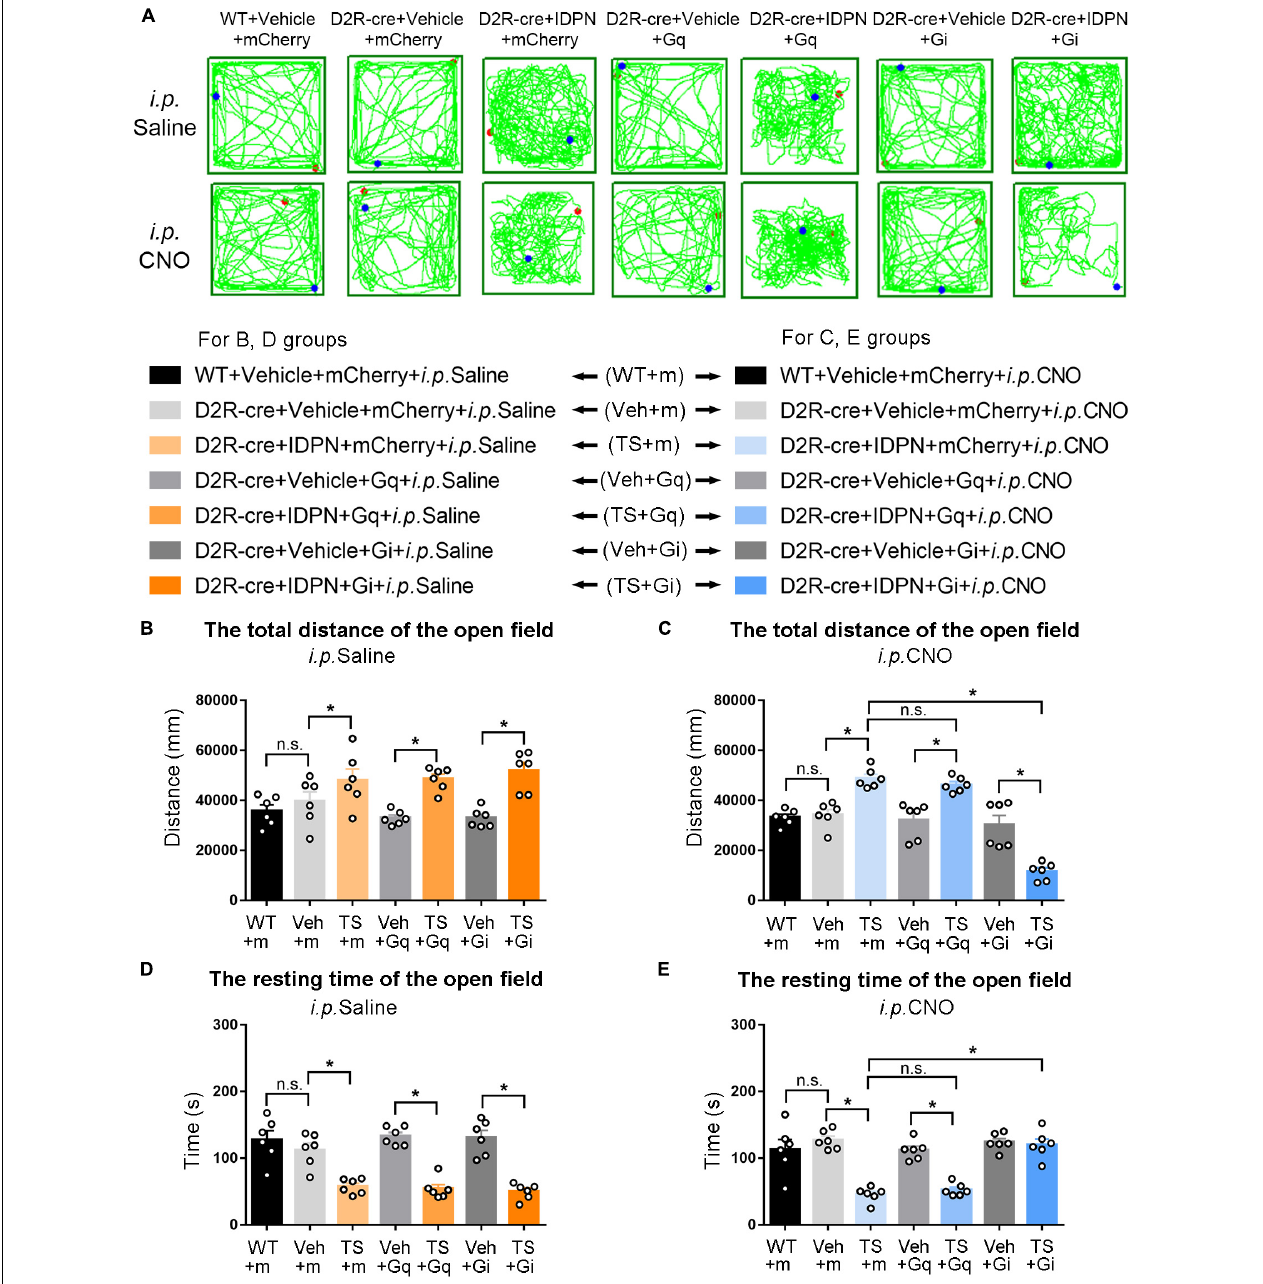
FIGURE 6 | Effects of activation or inhibition of D2R-containing neurons in the SNpc on total distance and resting time in the open-field test in mice. (A) Evaluations of the trajectory in the open-field test in mice 30 min after the injection of saline (i.p. Saline) or CNO (i.p. CNO) in the WT + Vehicle + mCherry + i.p. Saline group (WT + m), D2R-cre + Vehicle + mCherry + i.p. Saline group (Veh + m), D2R-cre + IDPN + mCherry + i.p. Saline group (TS + m), D2R-cre + Vehicle + Gq + i.p. Saline group (Veh + Gq), D2R-cre + IDPN + Gq + i.p. Saline group (TS + Gq), D2R-cre + Vehicle + Gi + i.p. Saline group (Veh + Gi), D2R-cre + IDPN + Gi + i.p. Saline group (TS + Gi), WT + Vehicle + mCherry + i.p. CNO group (WT + m), D2R-cre + Vehicle + mCherry + i.p. CNO group (Veh + m), D2R-cre + IDPN + mCherry + i.p. CNO group (TS + m), D2R-cre + Vehicle + Gq + i.p. CNO group (Veh + Gq), D2R-cre + IDPN + Gq + i.p. CNO group (TS + Gq), D2R-cre + Vehicle + Gi + i.p. CNO group (Veh + Gi), D2R-cre + IDPN + Gi + i.p. CNO group (TS + Gi) on day 23. (B) Total distance in the open-field test within 10 min in mice of each group 30 min after the injection of saline (i.p. Saline) on day 23. (C) Total distance in the open-field test within 10 min in mice of each group 30 min after the injection of CNO (i.p. CNO) on day 23. (D) Resting time in the open-field test within 10 min in mice of each group 30 min after the injection of saline (i.p. Saline) on day 23. (E) Resting time in the open-field test within 10 min in mice of each group 30 min after the injection of CNO (i.p. CNO) on day 23. Data are expressed as mean ± SEM ( n = 6 mice in each group), and the black line segment indicates the differences between groups, * represents P < 0.05 between marked groups, and n.s. represents P > 0.05 between marked